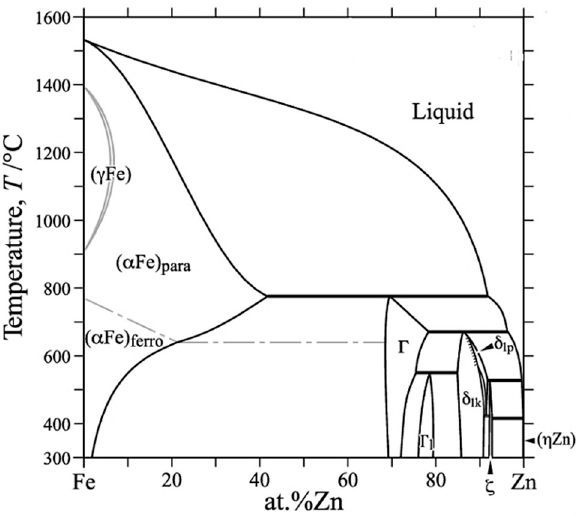
Figure 3. Fe-Zn phase diagram.